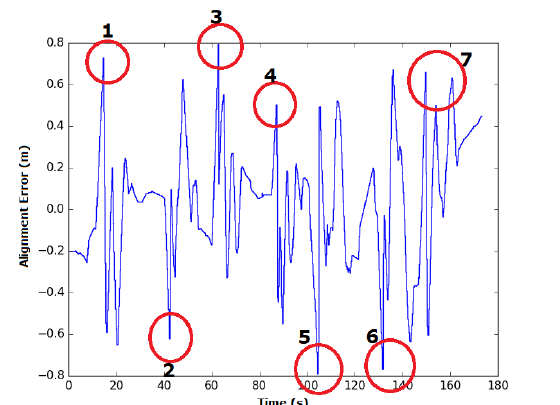
Figure 20. Variation in the alignment error of the robot during experiment 1 in manual mode. The spikes in the error occur during turns due to the robot’s topology and are circled in red, with a number representing the associated curve.